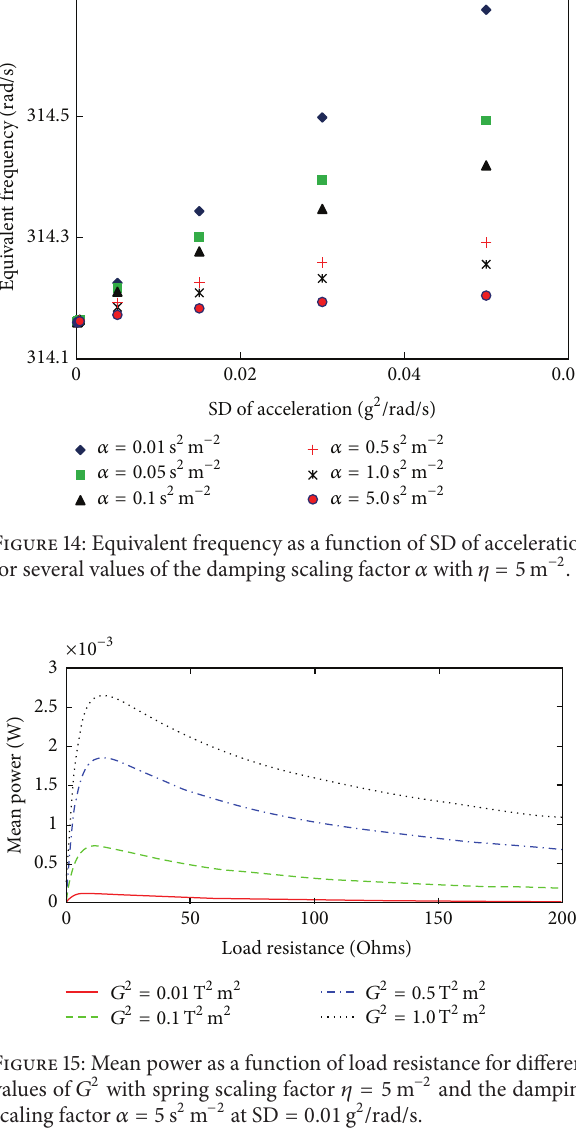
Figure 15. The plots are obtained by using (70) and (73)